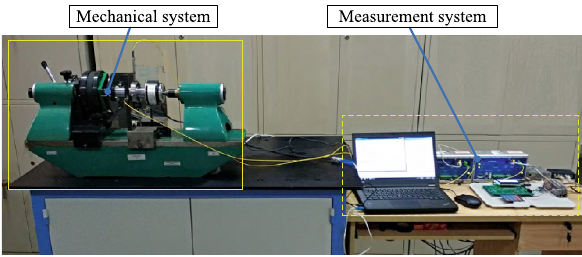
Figure 3. Test device to measure the radial run-out of the inner ring.